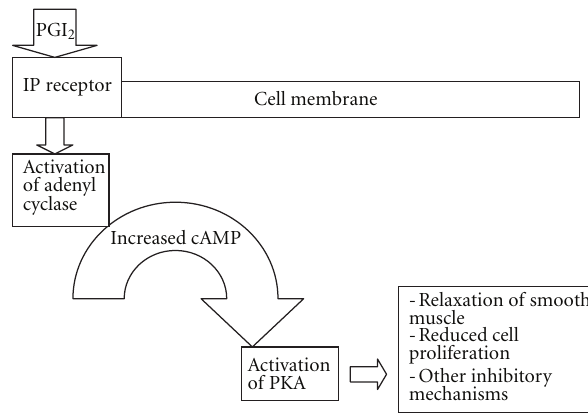
Figure 1: PGI 2 receptor